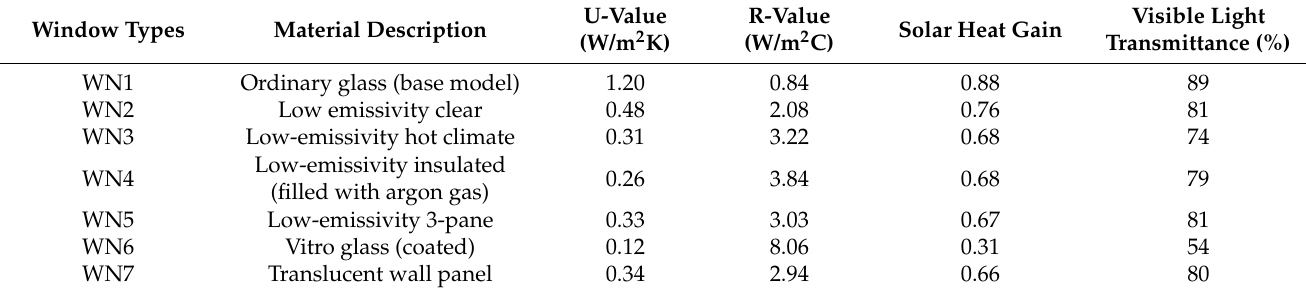
Table 3. Different types of window materials.